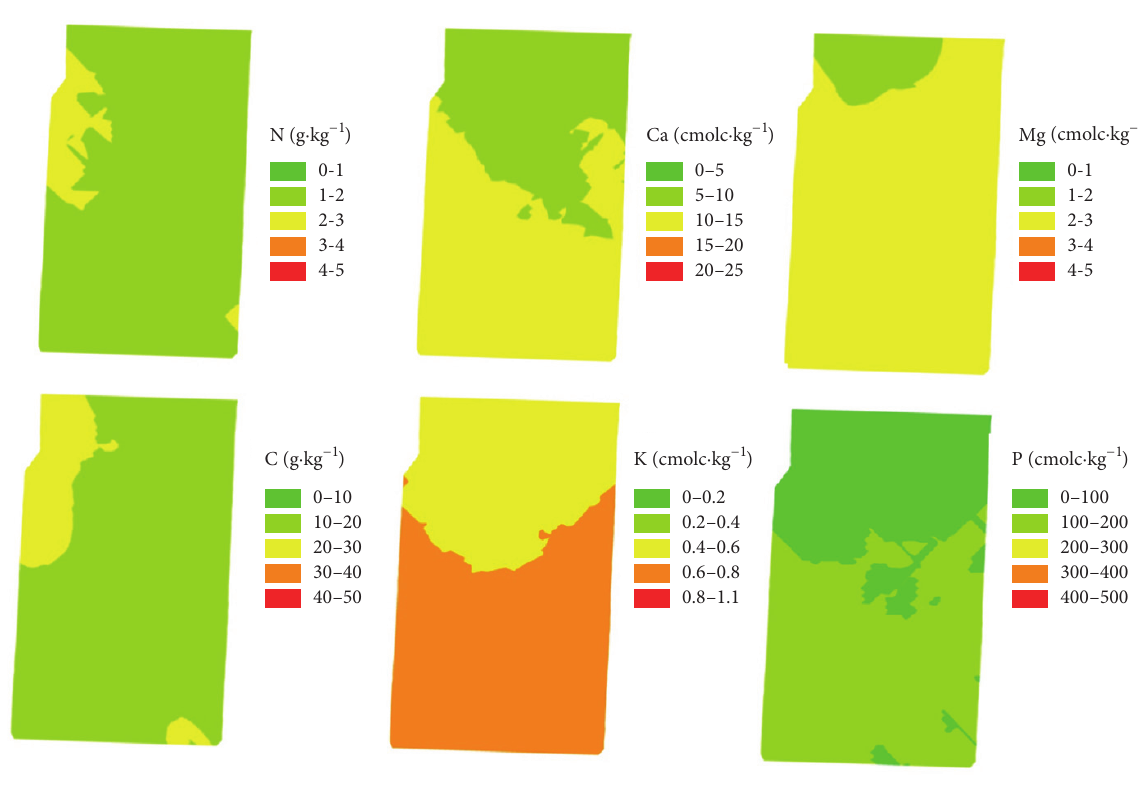
Figure 5: Spatial distribution of nutrients in the soils of vineyard 2 (horizon Ap).